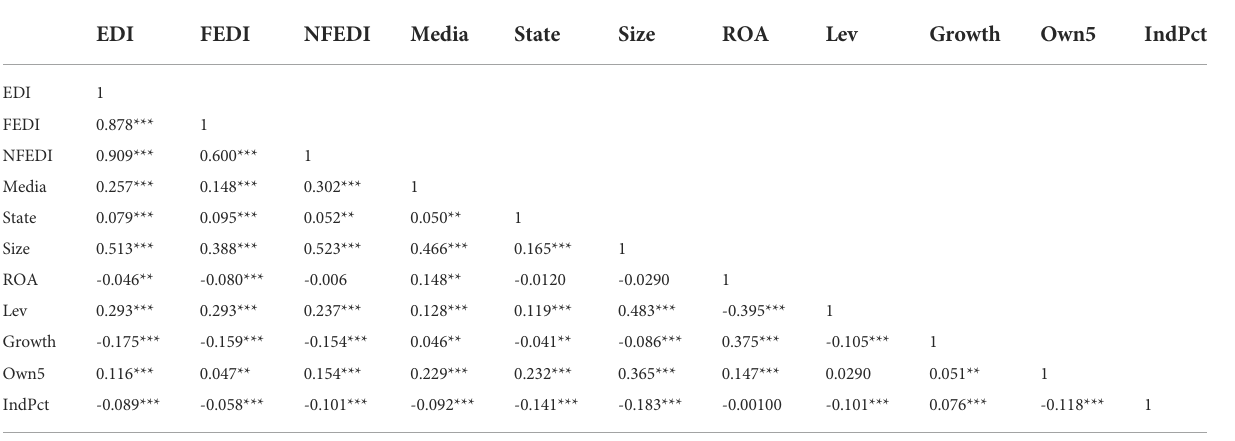
TABLE 4 Variable correlation coef fi cients.